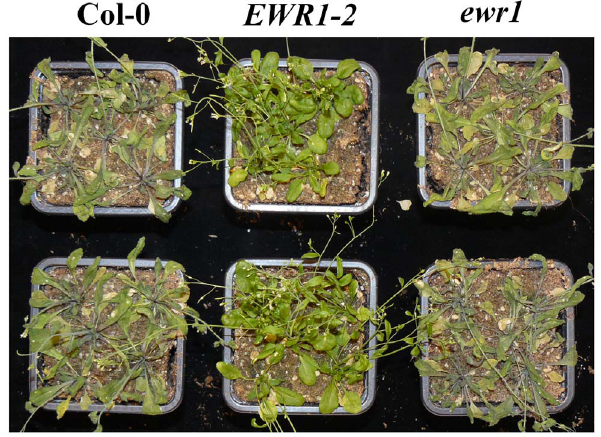
Figure 5. AtEWR1 over-expressing plants are tolerant to drought stress. Three weeks-old wild-type Col-0, AtEWR1 expressing line (EWR1-2) and AtEWR1 knock out line ( ewr1 ) plants were exposed to drought stress and picture was taken at 14 days post drought treatment. The assay was repeated three times and a representative of the replicates is